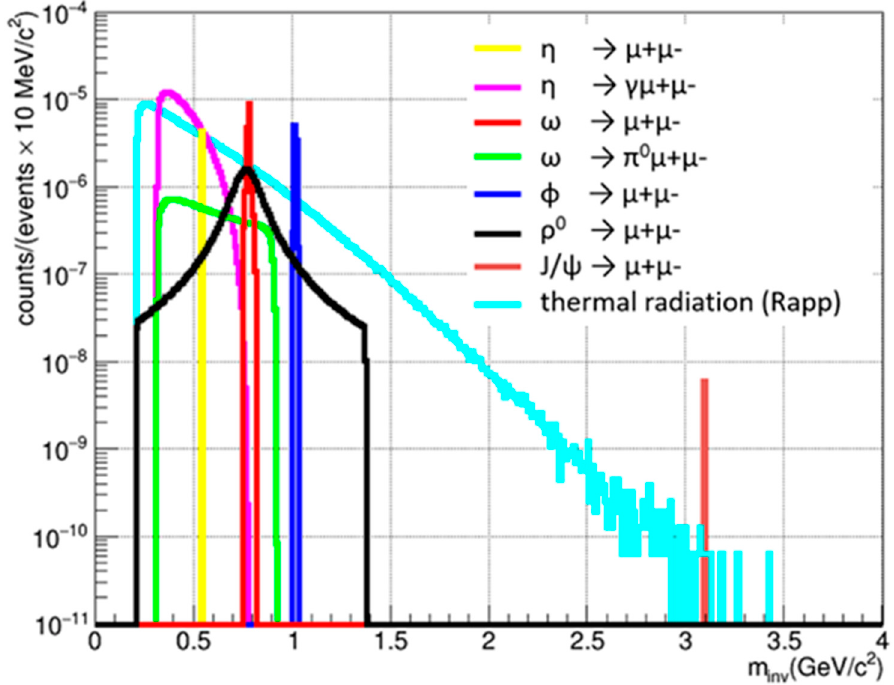
Figure 6. Dimuon invariant mass distributions from the decays of η , ω , ρ , ϕ , and J/ ψ mesons, and from thermal radiation [14] from the fireball in central Au + Au collisions at 8 A GeV/c, as calculated with the PLUTO generator [12].